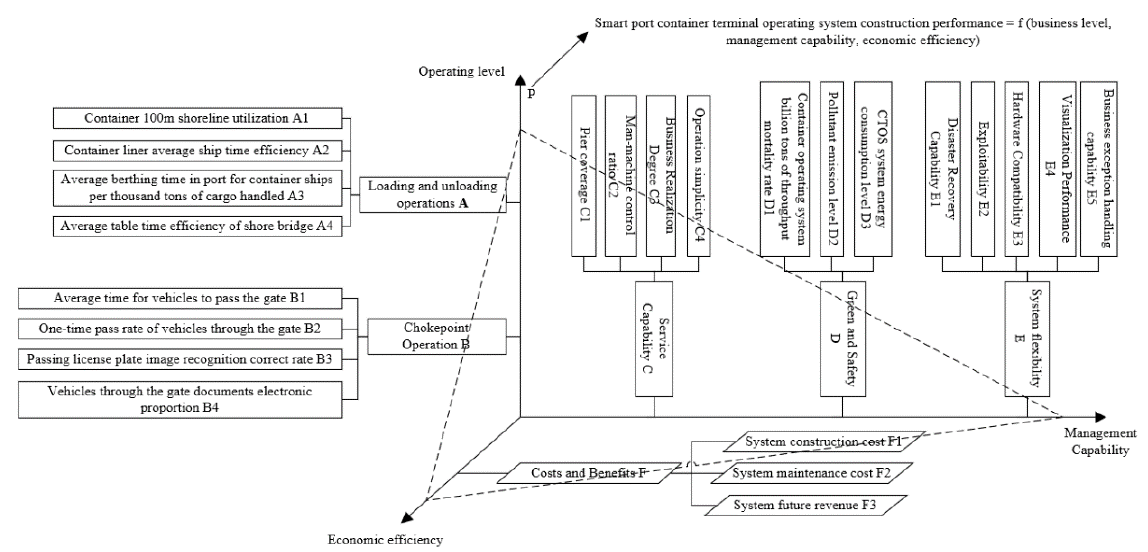
Figure 2. CTOS construction performance evaluation system.